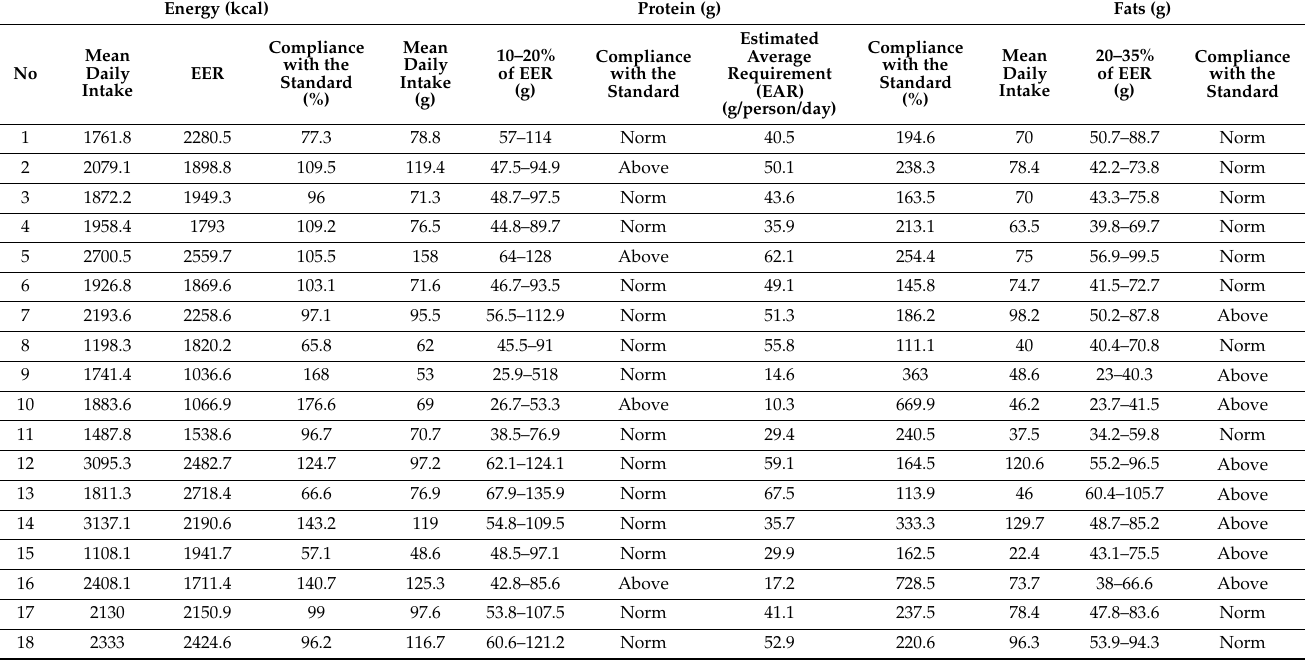
Table 3. Assessment of energy and macronutrient intake in people with